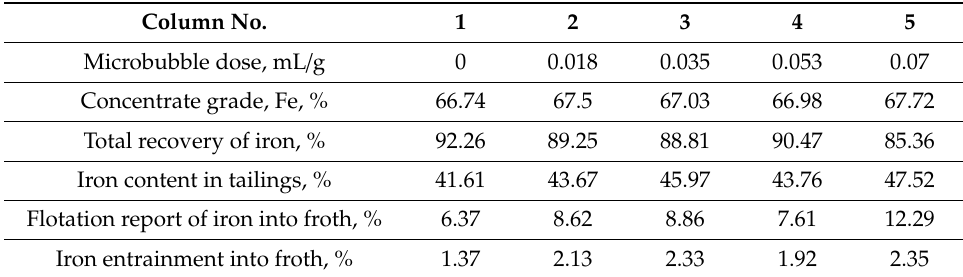
Table 2. Flotation of Magnetite / Ballotini mixture at varied microbubble doses *. Column No.